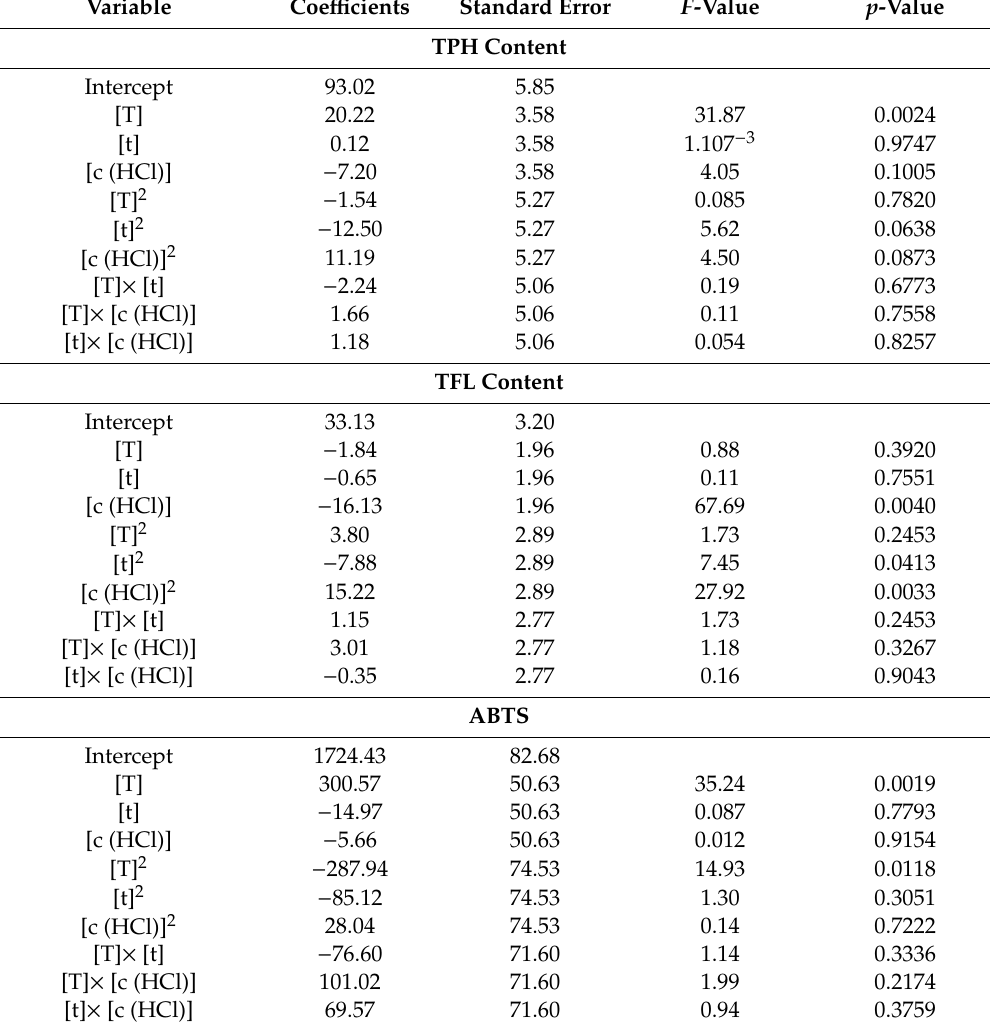
Table 3. Corresponding p -values for the selected response variable for each obtained coe ffi cient. Variable Coe ffi